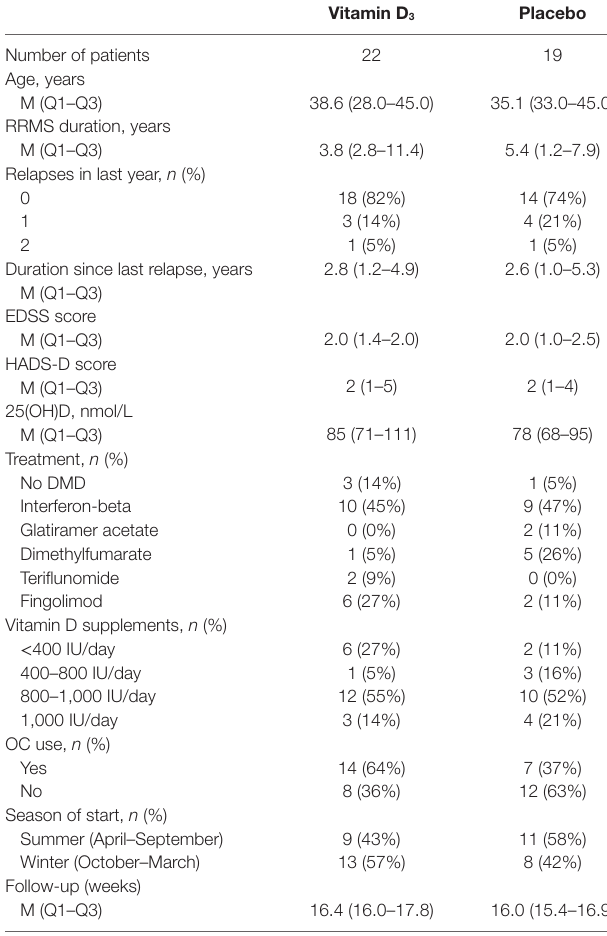
Table 1 | Baseline